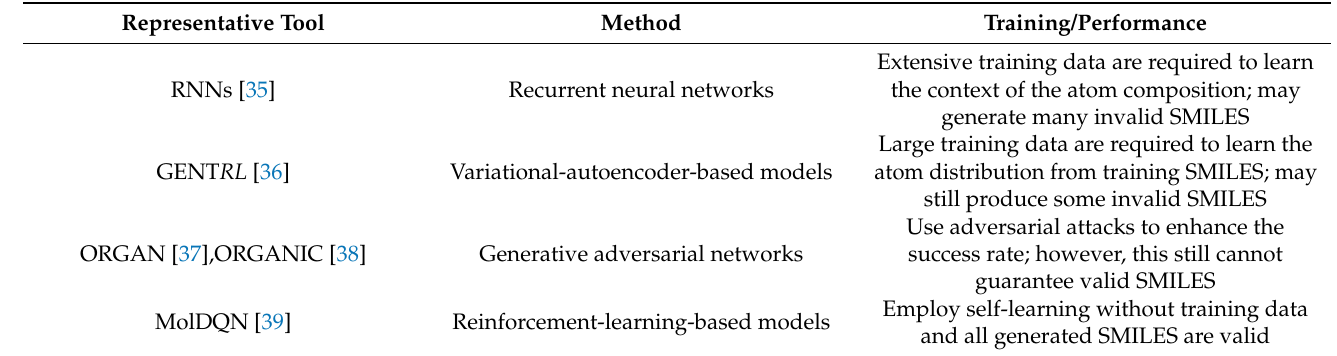
Table 1. Comparisons of existing deep-learning-based molecule design